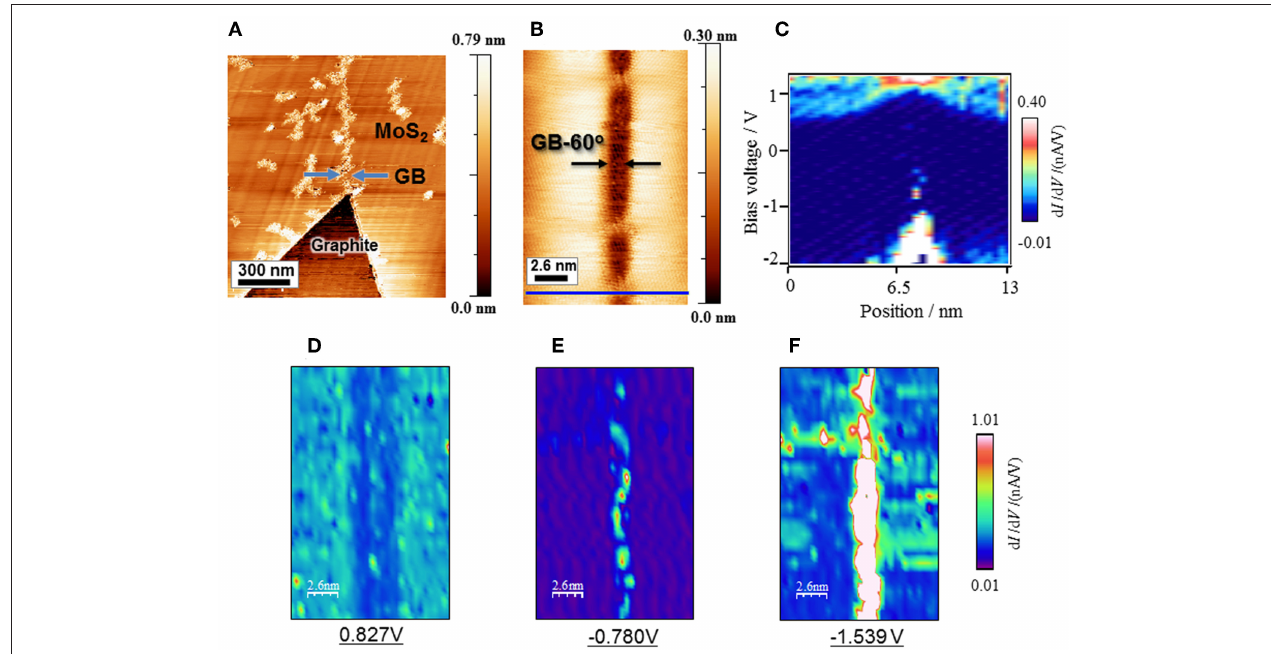
FIGURE 3 | (A) An STM image of MoS 2 grown on graphite with a grain boundary of 60 ◦ . (B) A magnified STM image around the GB-60 ◦ . (C) dI/dV mapping across the GB-60 ◦ measured along the blue line in (B) . (D–F) STS spectral image of the GB-60 ◦ measured with different bias voltage of 0.827, − 0.780, and − 1.539V,